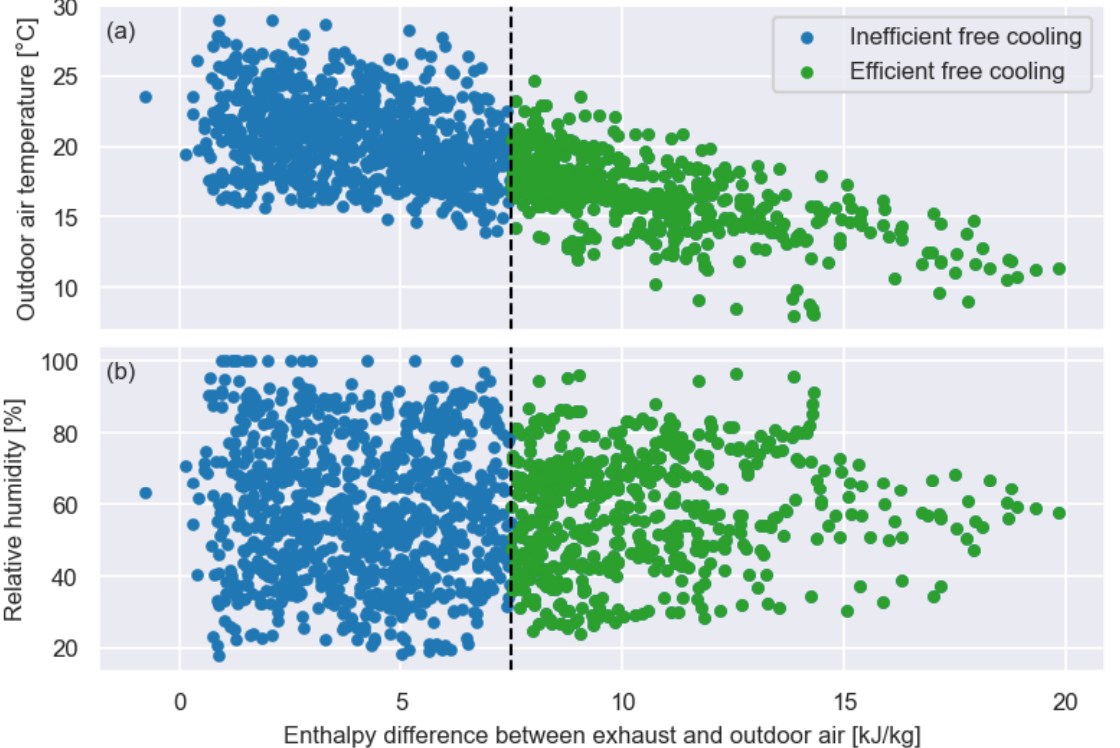
Figure 11. ( a ) Outdoor air temperature and ( b ) relative humidity for inefficient and efficient free Figure 11. (a) Outdoor air temperature and (b) relative humidity for inefficient and efficient free cooling as a function of the enthalpy difference between exhaust and outdoor cooling as a function of the enthalpy difference between exhaust and outdoor air.